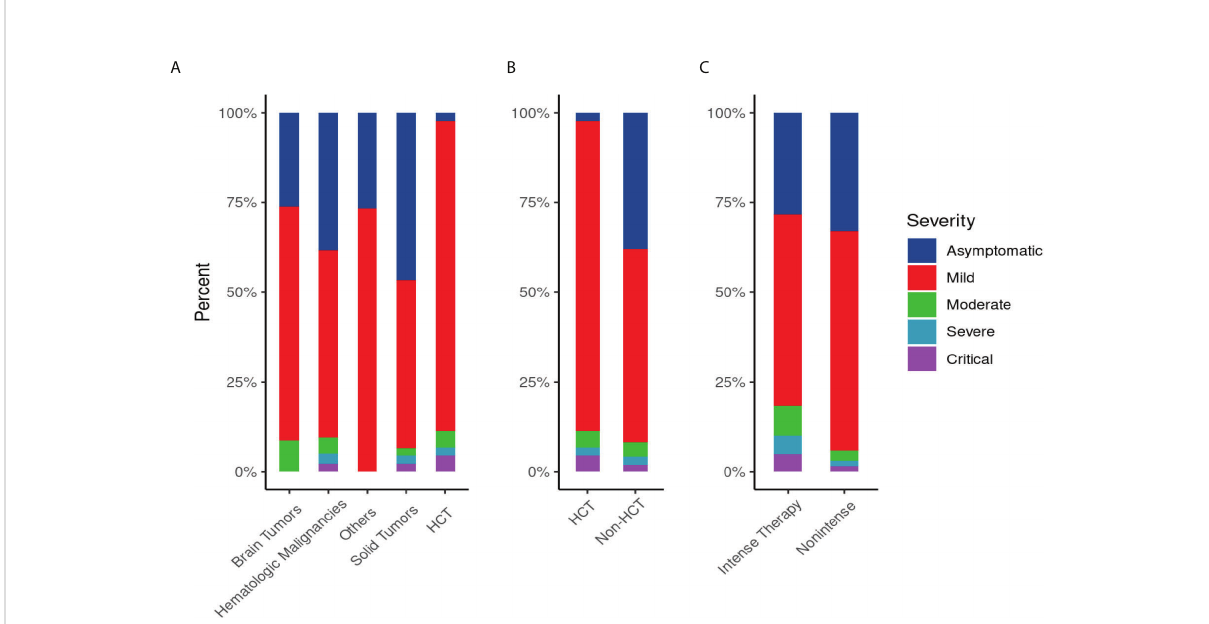
FIGURE 3 Disease Severity Score of COVID-19 infection by primary diagnosis (A), by type of therapy “ hematopoietic stem cell transplant (HCT) vs non HCT ” (B) , and by intensity of therapy(C): (A) Severity of COVID-19 infection by primary diagnosis: SVI was common in patients with hematological malignancy (13/136;10%), in patients who underwent HCT (5/44; 11%), followed by brain tumor (2/23; 8.6%) and solid tumor (3/ 45;6.6%). (B) Severity of COVID-19 infection in hematopoietic stem cell transplant (HCT) or non-HCT group: SVI in HCT (5/44; 11%) versus (18/ 219; 8%) in non-HCT group. (C) Severity of COVID-19 infection by intensity of therapy: SVI was common in patients who received intense therapy (11/60; 18%) versus (12/203; 6%) in patients received non-intense